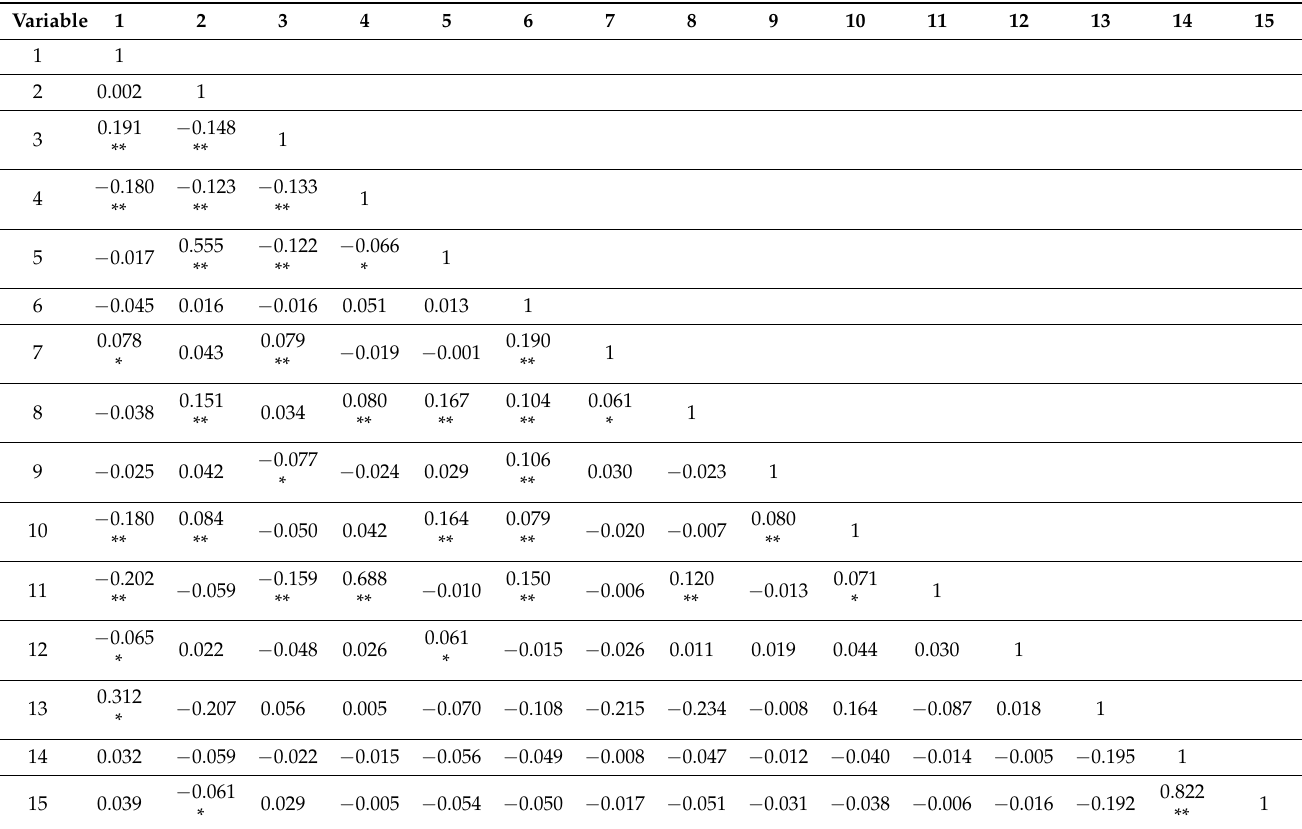
Table 3. Correlation matrix of variables.